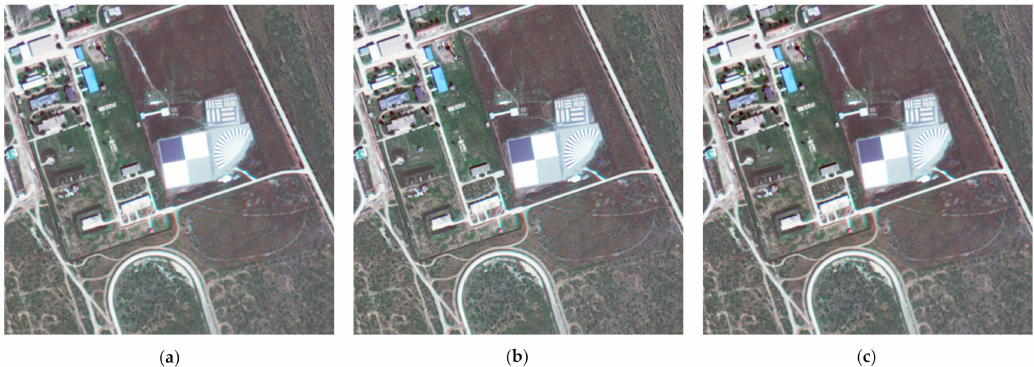
Figure 17. Images of Baotou on 31 August 2020. ( a ) Original image; ( b ) corrected image after Syn-AC; ( c ) corrected image after FLAASH. The retrieved AOD at 550 nm and retrieved CWV are 0.092 and 1.14 g/cm 2 ,